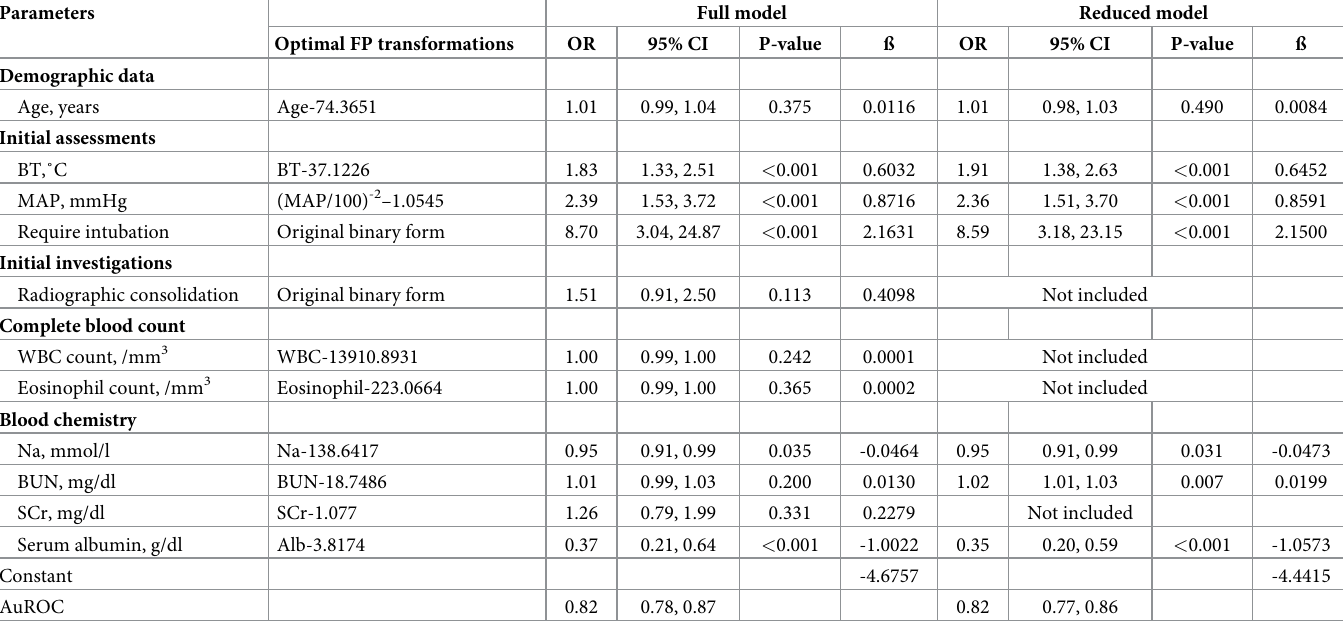
Table 3. Fractional polynomial transformation (of continuous parameters). Odds ratios from full and reduced multivariable logistic model (with cluster variance cor- rection) for predictors of in-hospital mortality of AECOPD patients (n = 923 admission visits). Missing data on predictors were imputed with multiple imputation with chained equation (partial mean